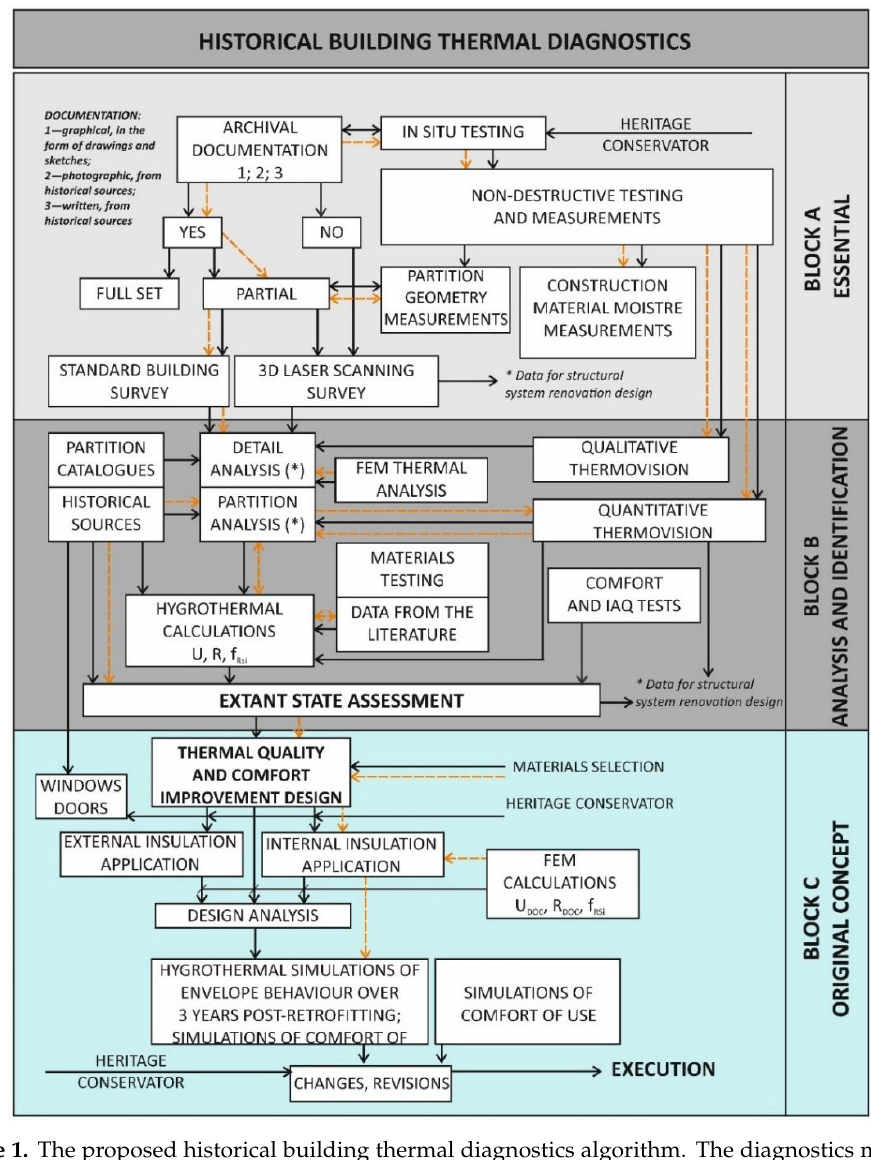
Figure 1. The proposed historical building thermal diagnostics algorithm. The diagnostics method selected in the case study is highlighted in orange (with a dashed line).